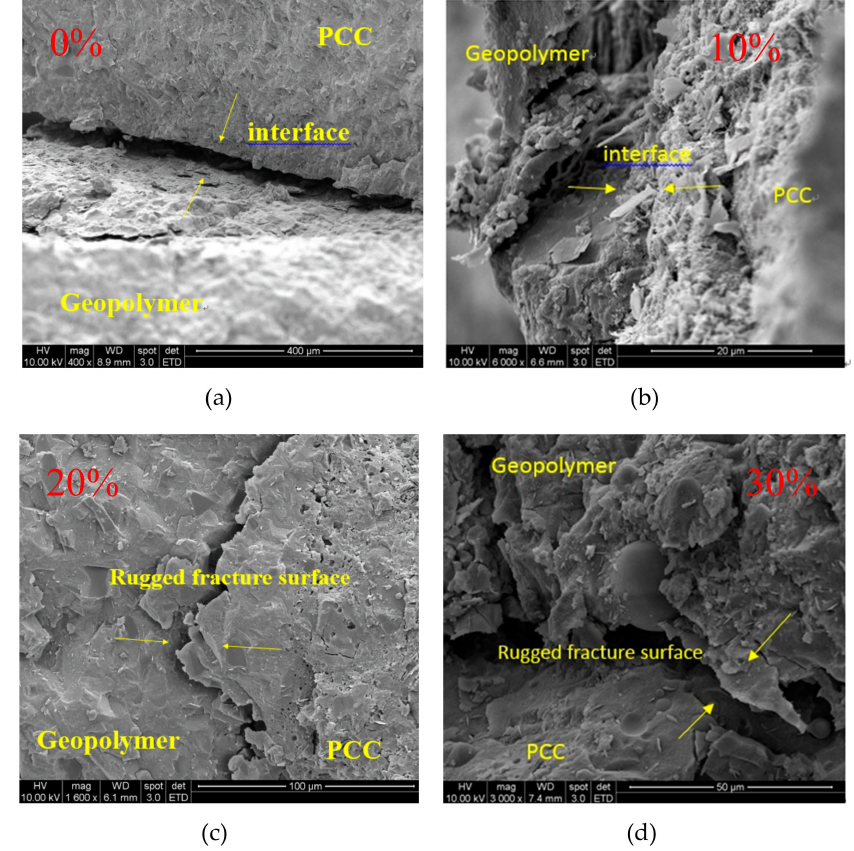
Figure 13. The microstructural characteristics of interphase when FGG was repaired with PCC. ( a ) Fly-ash replacement 0%; ( b ) Fly-ash replacement 10%; ( c ) Fly-ash replacement 20%; ( d ) Fly-ash replacement